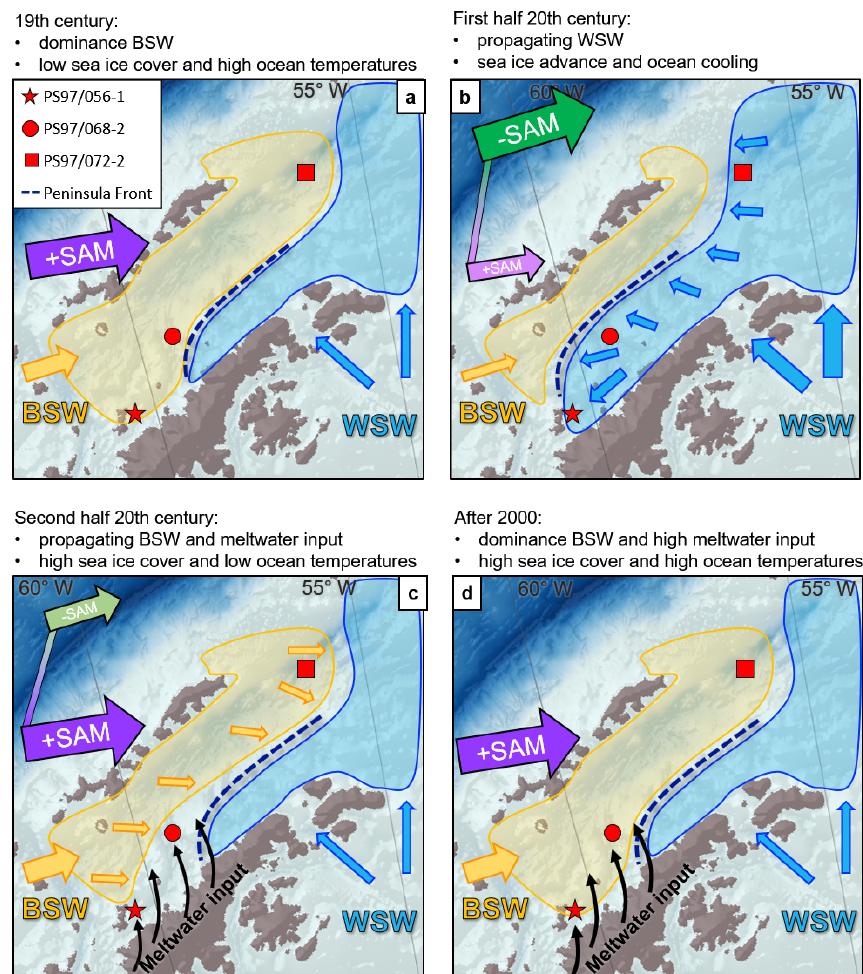
Figure 8. An illustration of the four environmental units and their dominant drivers of (a) low sea ice cover and high ocean temperatures from dominating BSW described in unit A, (b) moderate winter and spring sea ice cover with decreasing temperatures that propagate from the Weddell Sea to the southern WAP in unit B, (c) high but variable sea ice cover and ocean temperature lows under advancing BSW and positive SAM as well as additional meltwater pulses of unit C, and (d) high sea ice cover under a warm ocean temperature reversal as a result of BSW dominance and meltwater input from the AP in unit D. Thick and long arrows indicate a strong forcing, and thin and short arrows indicate a weak forcing. The arrows for SAM in units B and C describe the transition of the mode from the smaller to the bigger